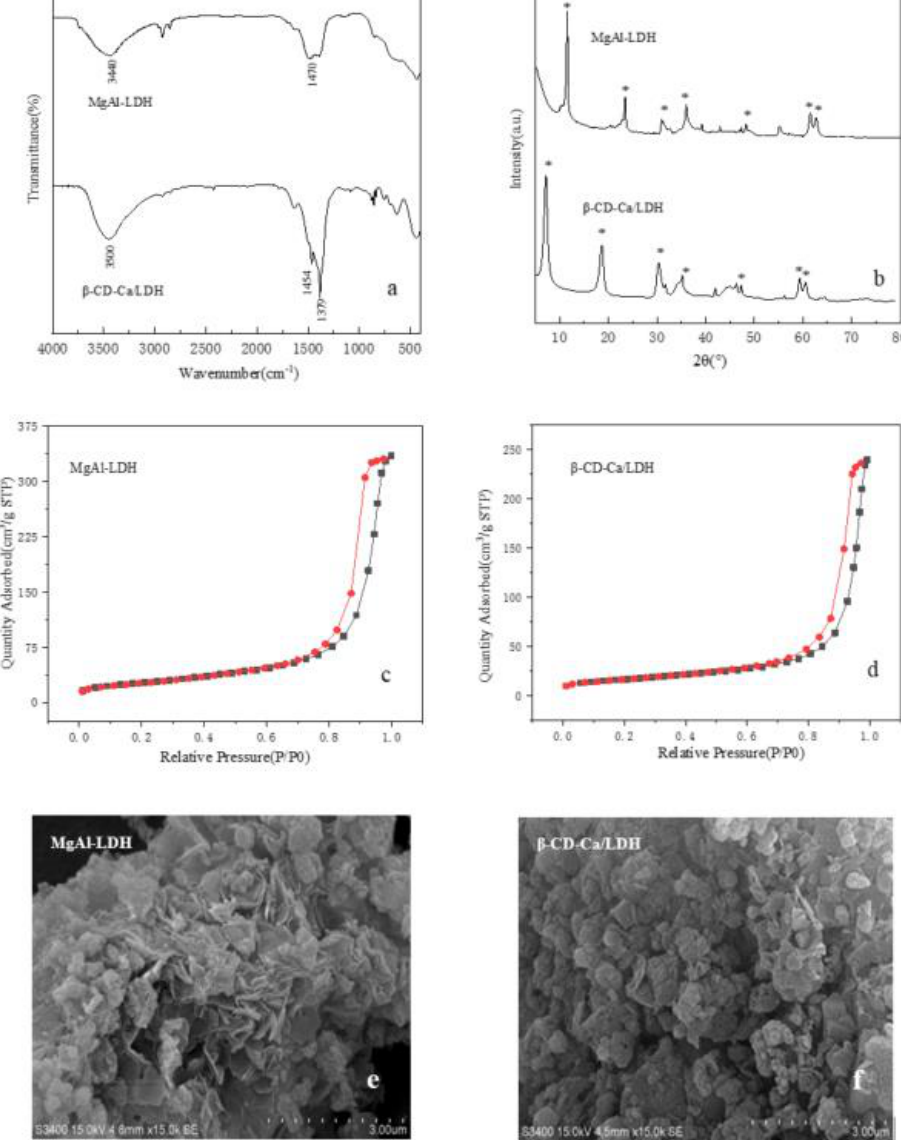
Figure 3. FT-IR spectra ( a ), XRD patterns ( b ), adsorption isotherms ( c , d ) and SEM images ( e , f ) of MgAl-LDH and β -CD-Ca/LDH (* signified characteristic peaks of hydrotalcites). Table 2 displayed the crystal structure parameters of MgAl-LDH and β -CD-Ca/LDH. Table 2. Lattice parameters of MgAl –LDH and β– CD – Ca/LDH. The spacing D of each characteristic crystal plane can be obtained by Bragg Diffraction Plane